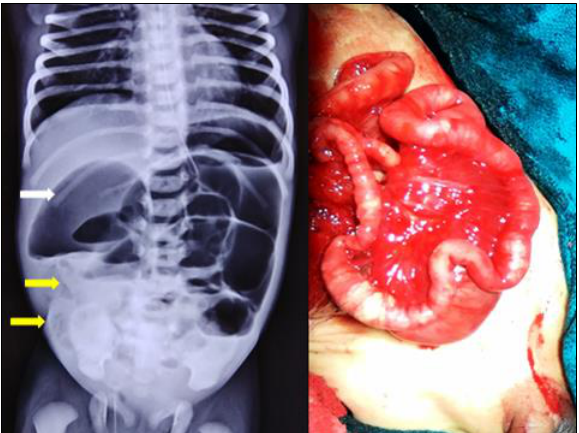
Figure 1: Abdominal radiograph (left) showing dilated small bowel loops with few air-fluid levels (white arrows); paucity of bowel gas in the central and right lower quadrant with few pellet like soft tissue shadows in right ileac fossa (yellow arrows). Intraoperative photograph (right) showing inspissated milk curds in the distal